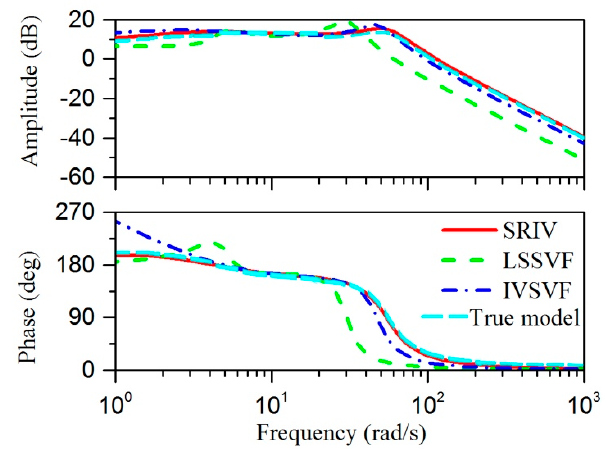
Figure 19. Bode plot of the EPS using different identification algorithms.